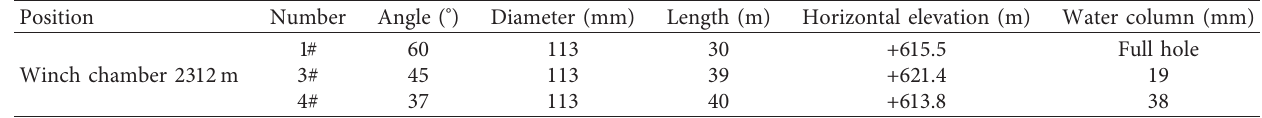
Table 1: Effluent from multiple boreholes.